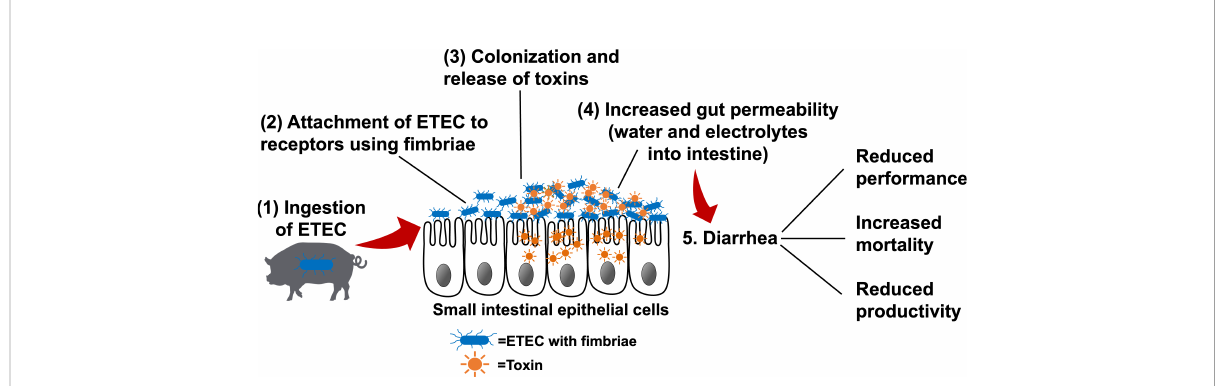
FIGURE 1 The pathogenesis of enterotoxigenic Escherichia coli (ETEC ) (1) ETEC are ingested by susceptible pigs and enter the gastrointestinal tract. (2) ETEC express fi mbrial adhesins, which mediate adherence to speci fi c receptors present on the intestinal epithelial cells. (3) Bacterial colonization occurs in the small intestinal mucosa. Once colonization is established, ETEC rapidly produce toxins (e.g., heat-labile, heat-stable, and/or Shiga toxins). (4) Enterotoxins stimulate water and electrolyte loss into the intestinal lumen, increase gut permeability, and/or transport across the epithelial cells to blood circulation, resulting in edema. (5) Increased gut permeability and massive water loss into the intestinal lumen lead to diarrhea, which results in the poor performance and productivity and increased mortality. Adapted from: Nagy and Feteke (12),